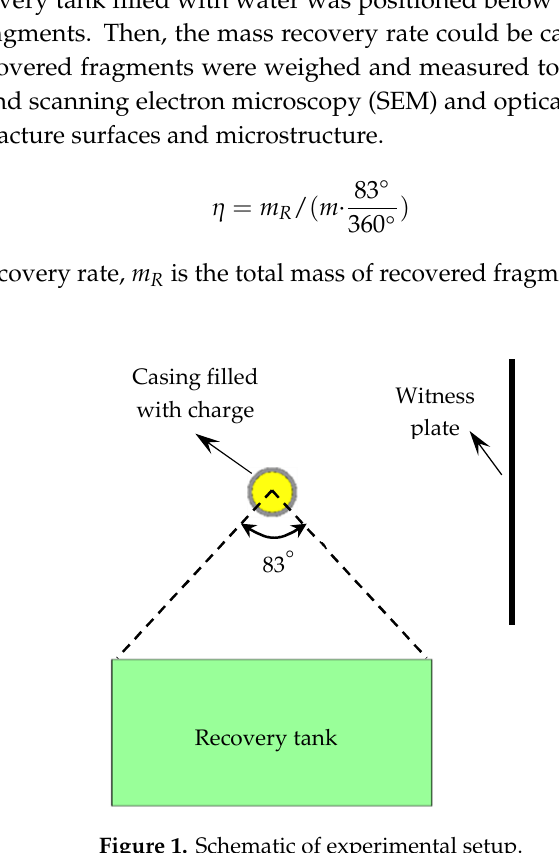
Figure 1. Schematic of experimental setup.